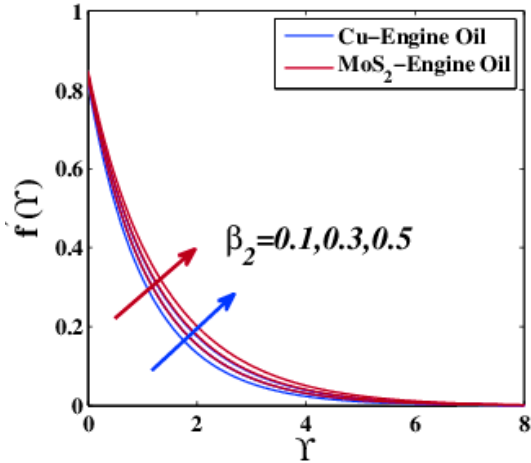
Figure 5. The effect of β 2 on velocity variation f (cid:48) ( Y ).